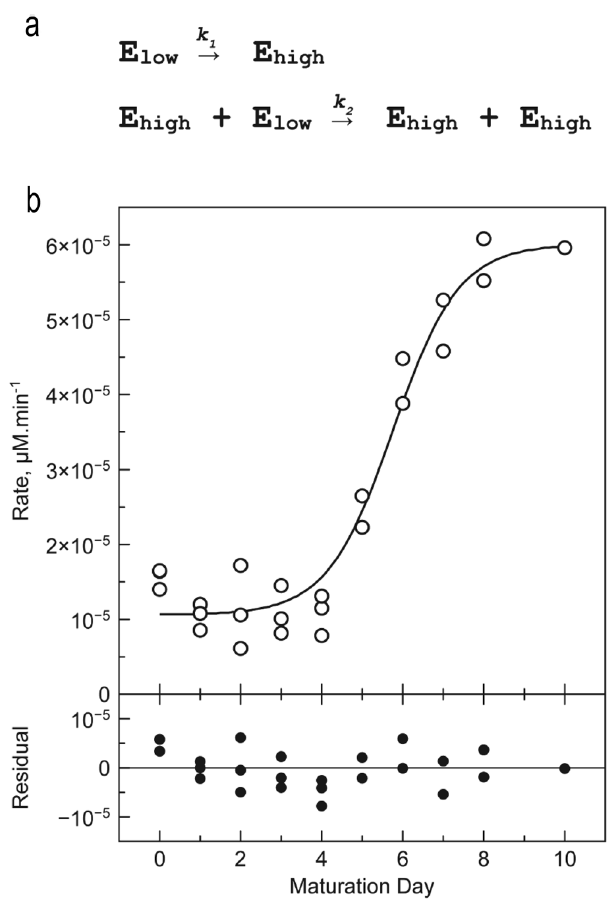
Fig. 6 Enzymatic characterization of the Cg MCA-I maturation process. a Two-step model describing the transition of enzymes of the E low population into enzymes of the E high population. b Hydrolytic activity determined during a 10-days maturation experiment. Cg MCA-I (16.5 µ M) is stored at 22 °C in 10 mM HEPES buffer pH 7.6, 150 mM NaCl. Reaction conditions: [ Cg MCA-I] = 2 µ M, [Z-GGR-AMC] = 50 µ M, 10 mM HEPES buffer pH 7.6, 150 mM NaCl, 10 mM CaCl 2 ( n = 3 independent